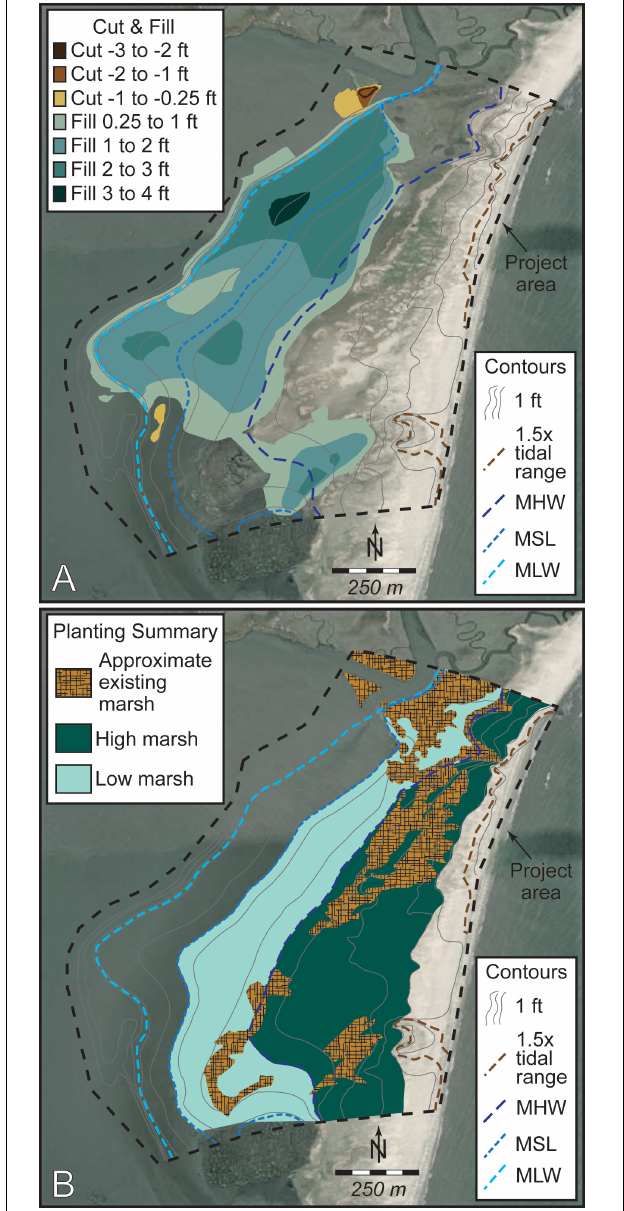
FIGURE 8 | Project area map showing (A) cut and fill areas and proposed grading of existing marsh; and (B) low and high marsh planting plan. Engineering design drawings use Imperial units as required for permit application drawings. 1 ft = 0.3048 m. MHW, mean high water; MLW, mean low water; MSL, mean sea level.